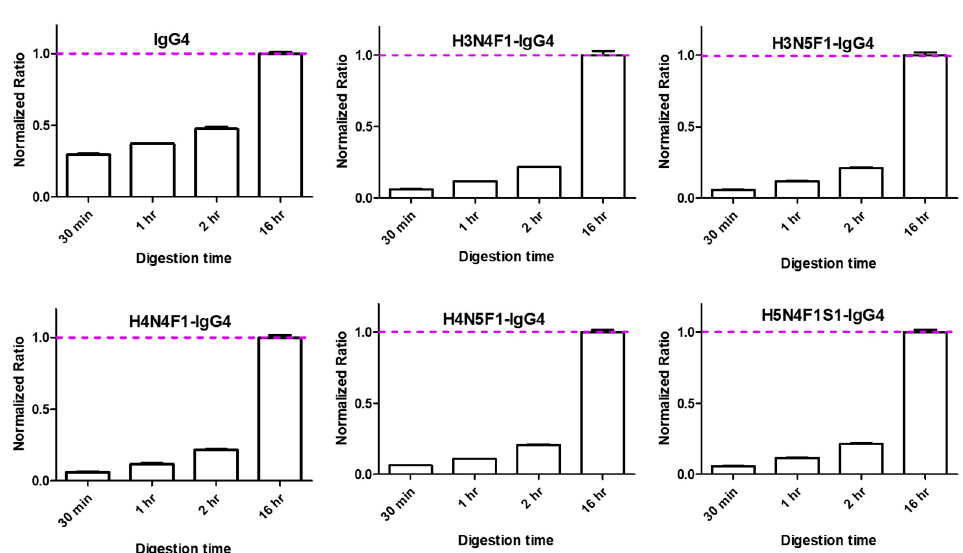
Figure 3. Results of optimized on-bead digestion time. Digestion times from 30 min to 16 h were conducted for comparison. The peak areas of the IgG4 surrogate peptide and selected IgG4 glycopeptides were performed. Peak area from the 16 h condition was used as the denominator for normalization and was indicated with a pink dash line. The standard deviation was calculated from technical replicates ( n = 3).